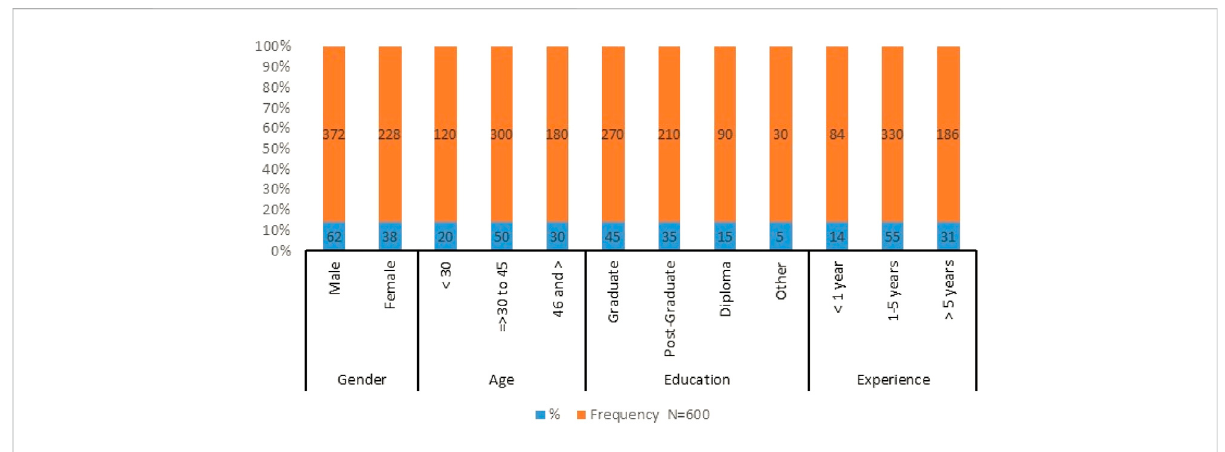
FIGURE 3 Demographic